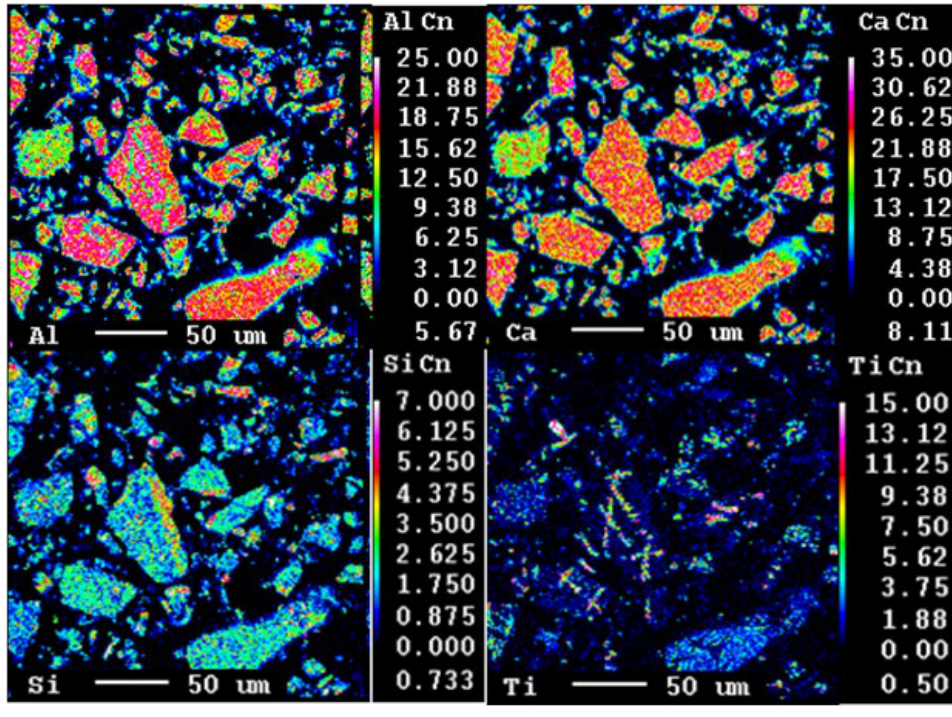
Figure 3 . Elemental mapping of the slag using EMPA . Figure 3. Elemental mapping of the slag using EMPA. Table 3 . Percentage mass quantification of selected elements in the slag by EMPA .